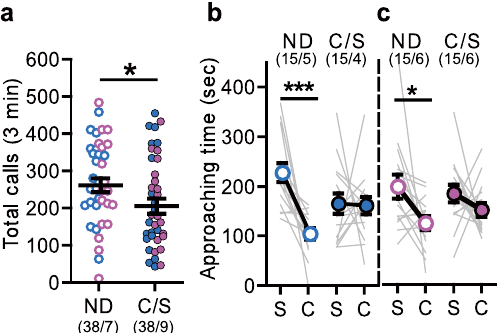
Figure 1. Effects of cesarean section (C/S) delivery on pups’ sociability. ( a ) Number of ultra-sonic vocalization (USV) calls at postnatal day (PD) 8 (naturally delivered [ND]: male = 19, female = 19, C/S delivered [C/S]: male = 19, female = 19; p = 0.039). ( b , c ) Approaching time to the stranger cage (S) and the empty cage (C) in the three-chamber social interaction (3-CSI) test. [( b ) male, ND: p < 0.001, C/S: p = 0.751; ( c ) female, ND: p = 0.030, C/S: p = 0.303]. Male offspring, blue circles; female offspring, pink circles. Data represent the mean ± SEM. The numbers in parentheses indicate the numbers of mice tested and their litters (mice/litters) in each group. * p < 0.05, *** p <